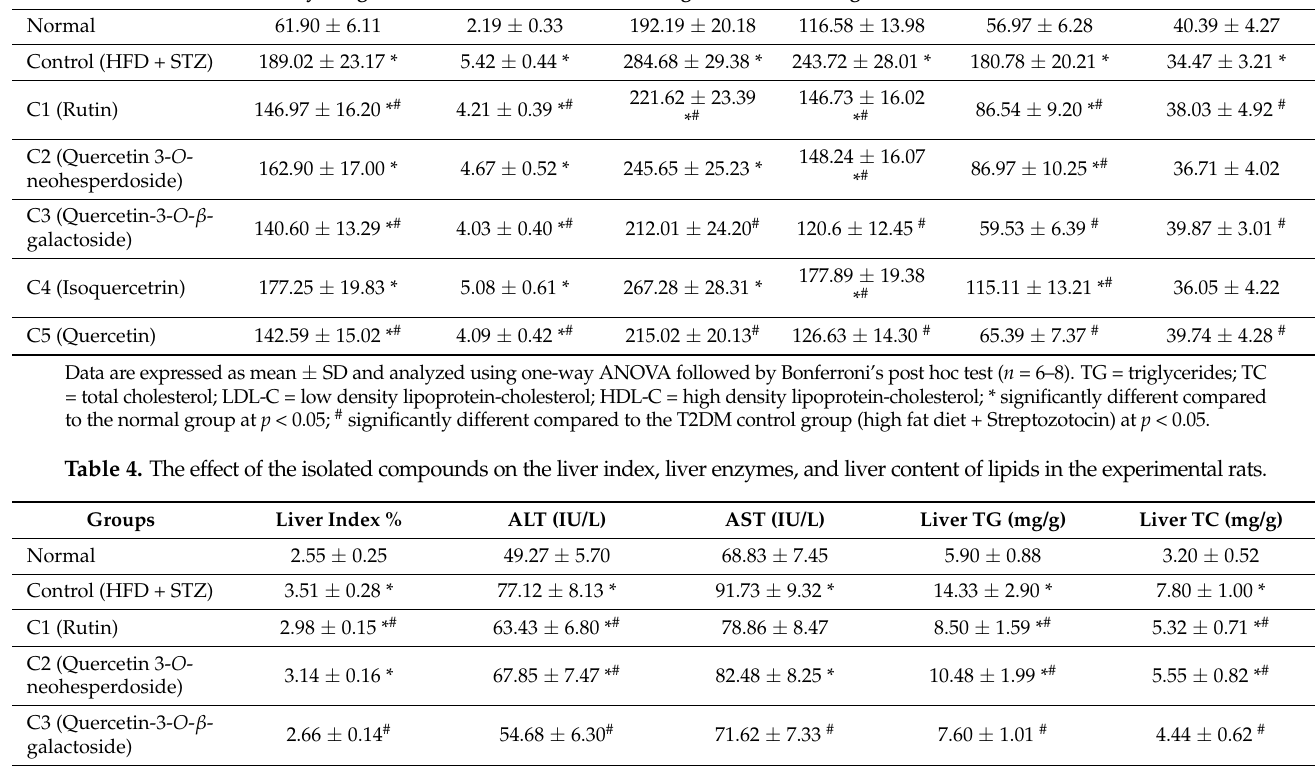
Table 3. The effect of the isolated compounds on the body weight, adipose tissue index and lipid profile of the experimental rats. Groups